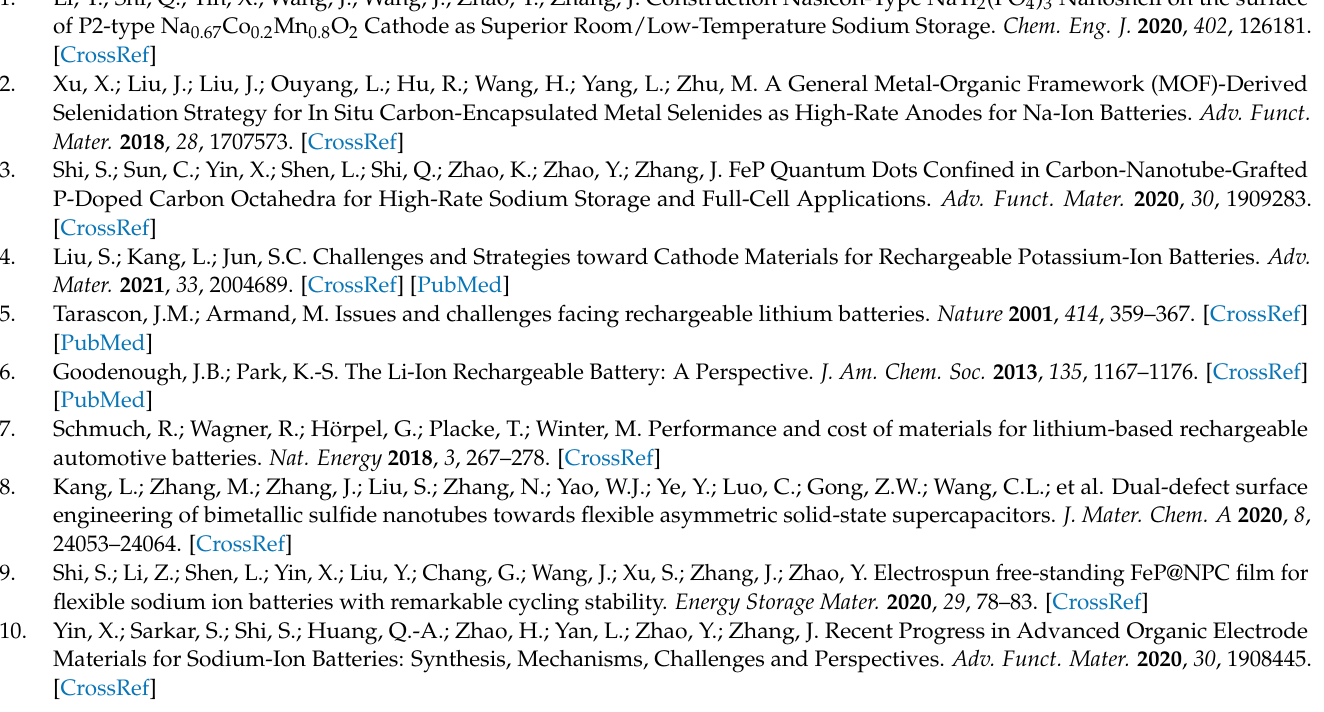
Figure S3: (a,b) SEM images of PO-VO 2 nanosheets; Figure S4: The rate performance of the contrast sample VO 2 at different current densities at a voltage of 0.2–1.5 V; Figure S5: The galvanostatic charge–discharge curves of PO-VO 2 in different cycle numbers at a voltage of 0.2–1.5 V and a current density of 1 A g − 1 ; Figure S6: The galvanostatic charge–discharge curves of the contrast sample VO 2 in different cycle numbers at a voltage of 0.2–1.5 V at a current density of 0.1 A g − 1 ; Figure S7: The cycling performance of the contrast sample VO 2 at a current density of 0.1 A g − 1 at a voltage of 0.2–1.5 V; Figure S8: The EIS plot of the contrast VO 2 at 0.01–10 6